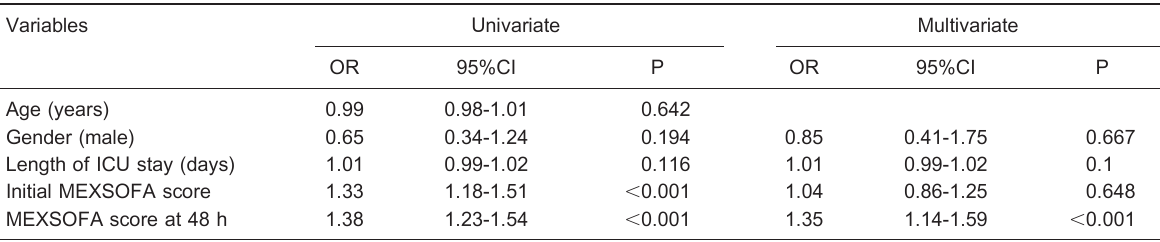
Table 6. Univariate and multivariate logistic regression analysis for indentifying independent risk factors for mortality in the intensive care unit (ICU).